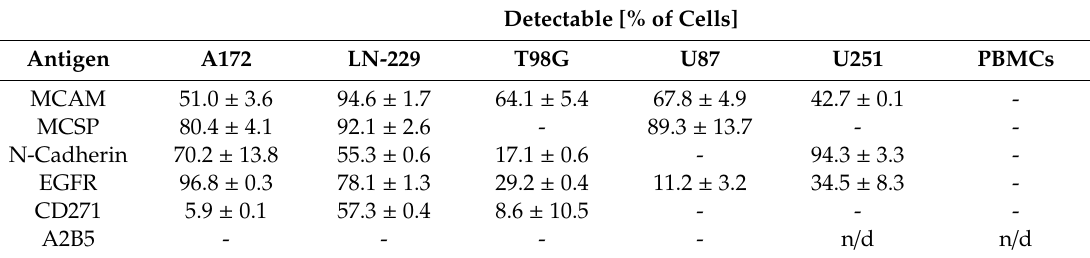
Table 2. Cell surface protein detection on cell lines by